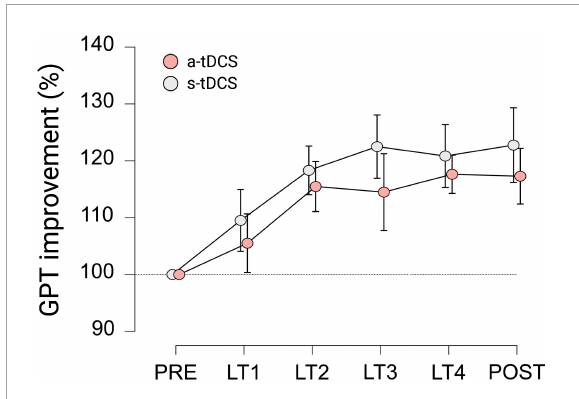
FIGURE2 Motor performance of LH trained during learning trials (LT) of GPT for both groups. All values are normalized to values obtained at PRE, representing percentage improvements. Displayed are mean ± 95% confidence